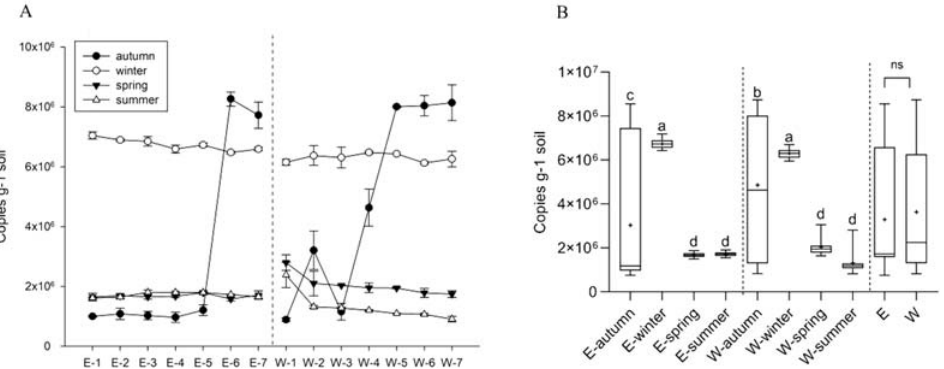
Figure 1. ( A ) Line plots of differences in abundance of nitrogen − fixing bacteria with elevation. ( B ) box plots of abundance of nitrogen − fixing bacteria in samples from different seasons and slope aspects. a, b, c, d: indicates significant difference at p < 0.05 level. ns: no significance.